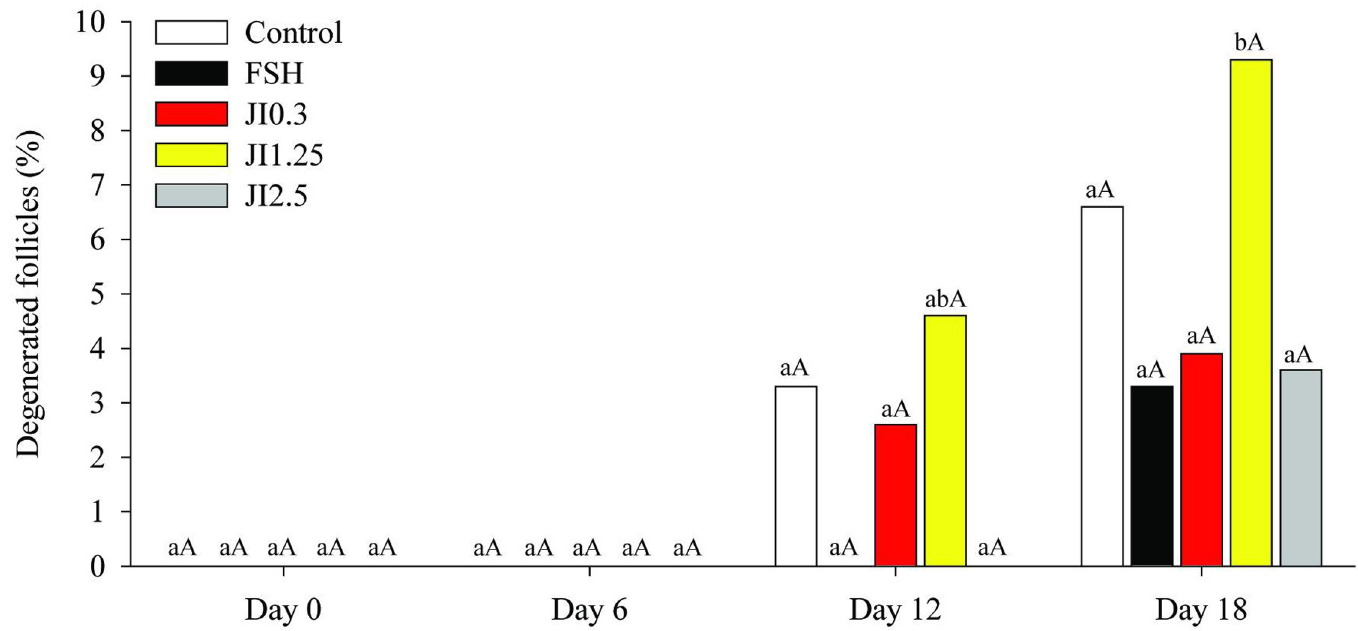
Fig 2. Percentage of degenerated follicles at different time point (D0, D6, D12, D18) in MEM + (Control), FSH or in J . insularis 0.3, 1.25 or 2.5 mg/mL (JI0.3, JI1.25 or JI2.5 respectively). D: day, MEM + : Minimal essential medium supplemented, FSH: recombinant bovine follicle stimulating hormone, JI: J . insularis . A total of 342 secondary follicles were distributed in the different treatments (n = 6 replicates). a,b,c,d Different letters denote significant differences among time for a given treatment group ( P < 0.05). A,B Different letters denote significant differences among treatment groups within the same time point (P <